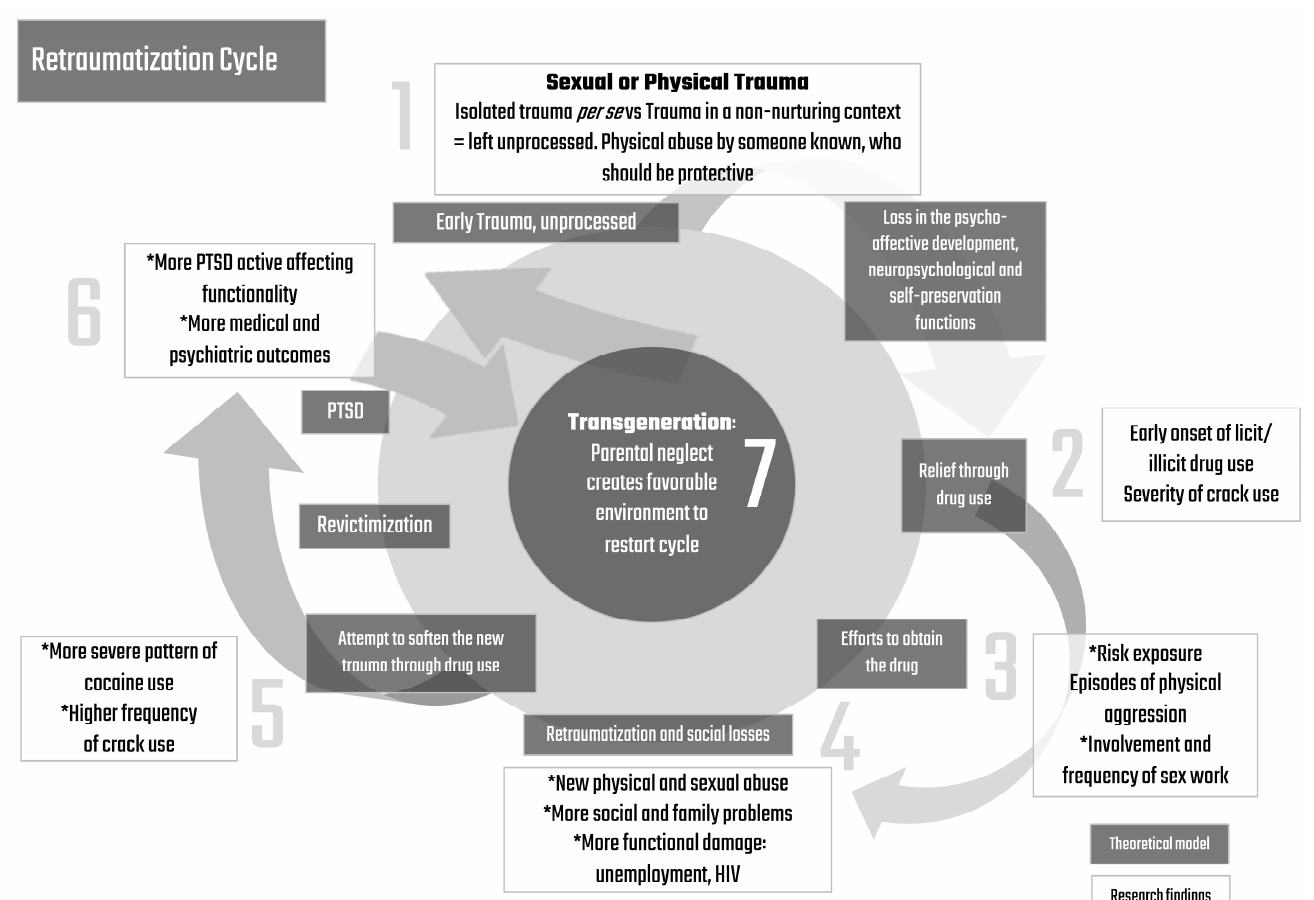
Figure 2. Graphic representation of the Retraumatization Cycle. * Data in which women were more exposed than men.